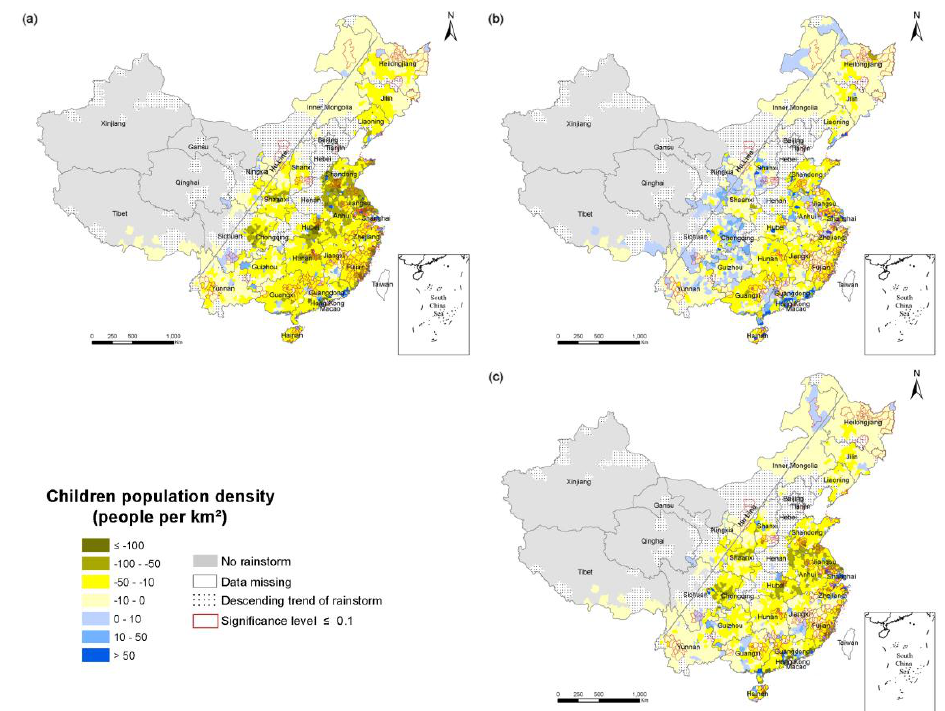
Figure 8. The change in the density of the child population in the RSHA ( a ) from 1900 to 2010; ( b ) from 1990 to 2000; ( c ) from 2000 to 2010.